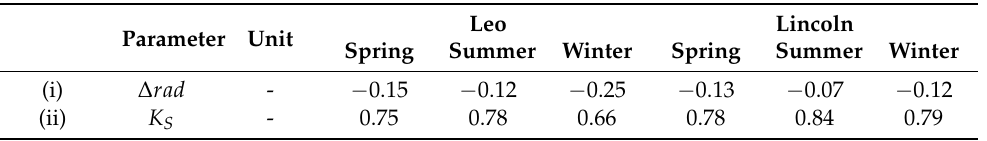
Figure 3. Transfer functions ∆ ET 0 ( ∆ rad ) for locations ( a ) “Leo” and ( b ) “Lincoln” with “Geo” as reference station. Table 4. Reduction in shortwave radiation ( ∆ rad ) and resulting K S -values used for the estimation of ET 0, Ks . All values have been calculated for spring equinox as well as winter and summer sol- stice.